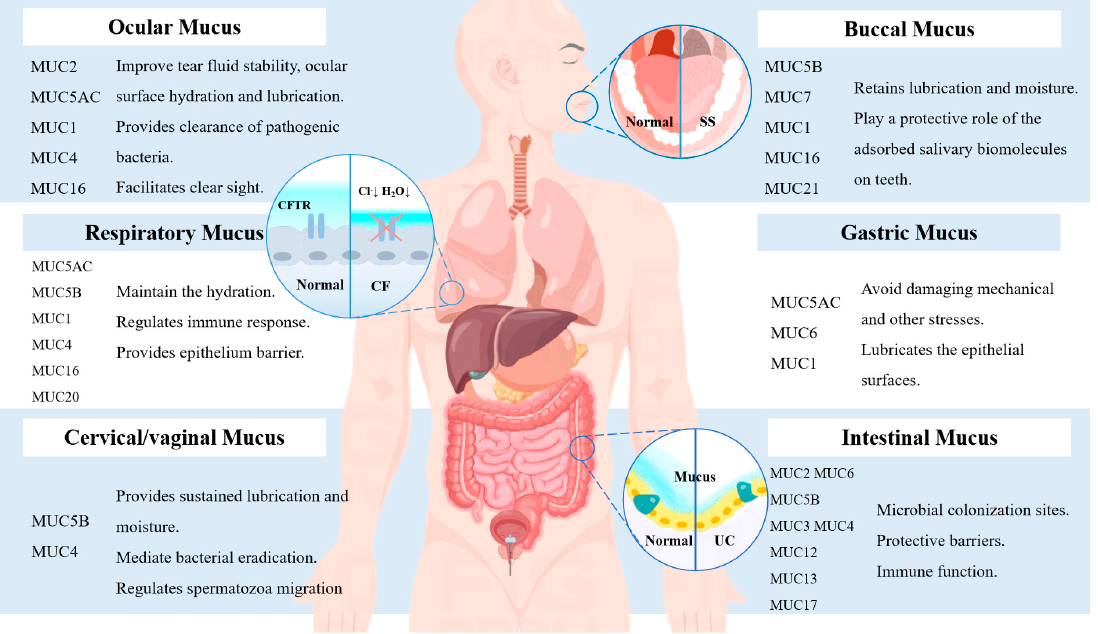
Figure 1. Diagram depicting a broad overview of mucus distribution, variation, and disorders linked with mucus throughout the body. The profit in the ocular cavity is mostly based on MUC1/2/5AC16, which has a primary role to lubricate and clean the mouth. Mucus in the respiratory tract is mostly MUC1/4/5B, and its primary function is to establish a barrier while also keeping the respiratory tract moist and participating in the immune response. The cervical/vaginal tract mucus is mostly MUC5 B/4, which has lubricating, antimicrobial, and sperm-motility-enhancing properties. The mucus in the oral cavity is mostly MUC7/6/21/5B, which has lubricating and moistening properties. The mucus in the stomach is primarily MUC5AC/6/1, which lubricates epithelial cells and prevents mechanical injury. Mucin in the intestine is primarily MUC6/5B/3/4/2/17, which serves as a protective barrier and provides microbial